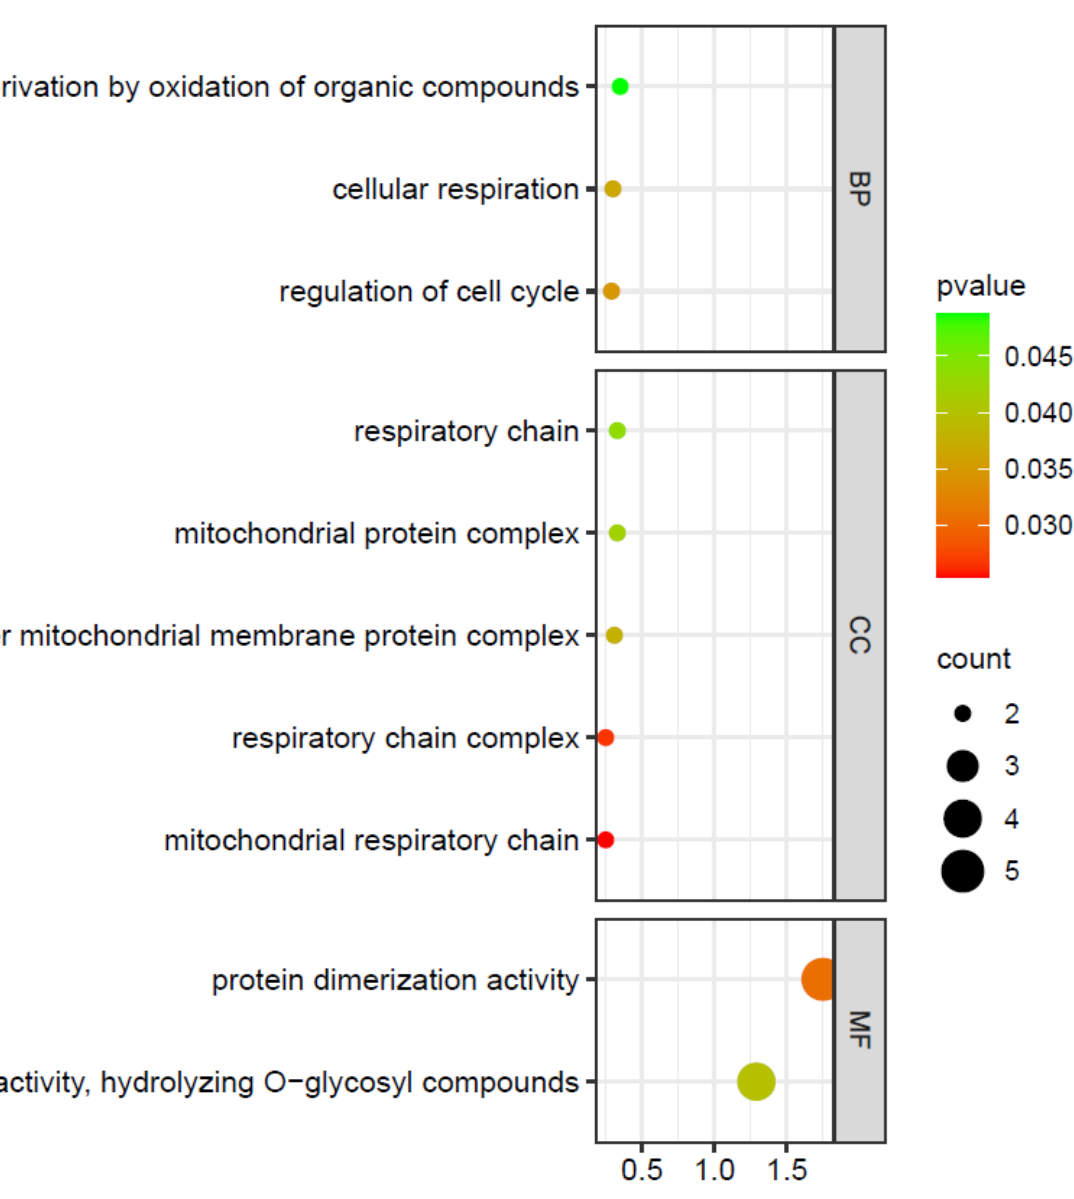
Figure 9. Bubble map of GO enrichment of ZmIDD-target genes. Genes were listed in Table S12. The X -axis represents the Rich Ratio. Rich Ratio = Term Candidate Gene Number/Term Gene Number. The Y -axis represents the GO Term. The size of the bubble represents the number of different genes annotated to a GO Term, and the color represents the enriched p value. 0 < p value < 1. The smaller the p value, the more significant the GO enrichment.